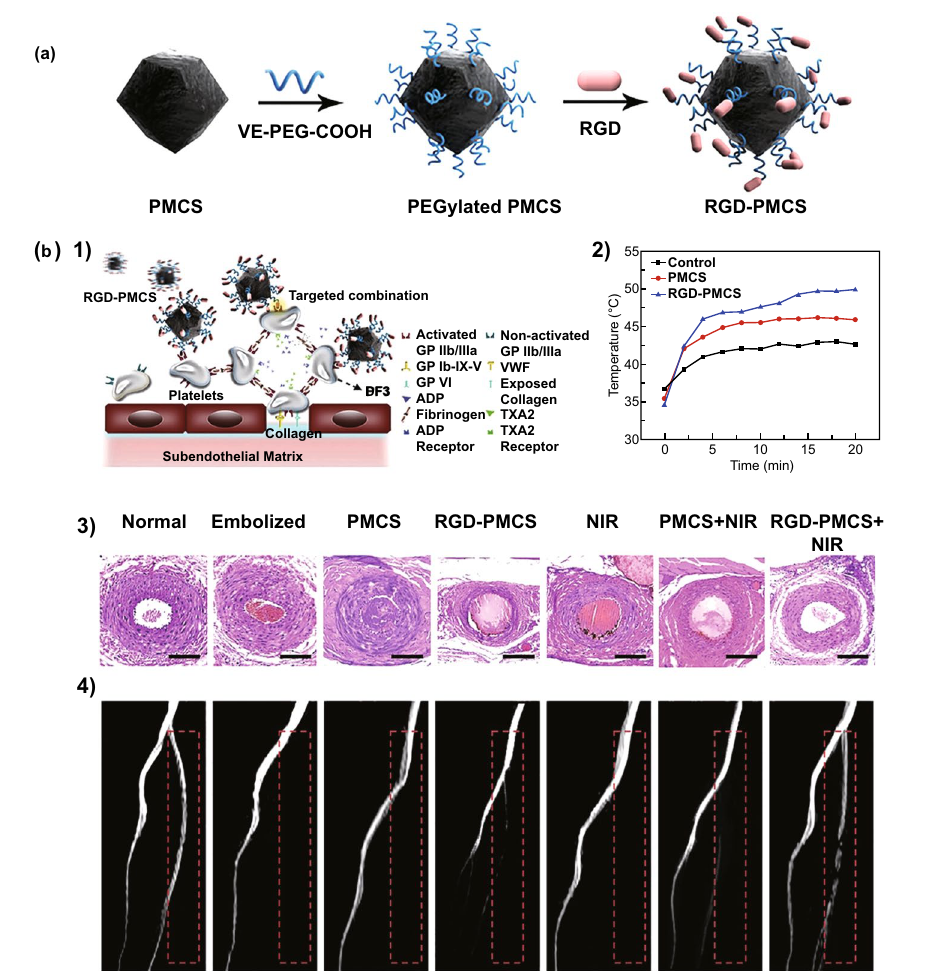
Fig. 8 a Schematic illustration of RGD-PMCS. b Schematic illustration for thrombus specific targeting of RGD-PMCS ( 1 ); the temperature of treated limb of mouse after the administration of PBS, PMCS, and RGD-PMCS and irradiated by 808 nm NIR laser ( 2 ); H&E staining images ( 3 ) and MRI ( 4 ) of the treated limb after different treatments [117]. Copyright 2019 Creative